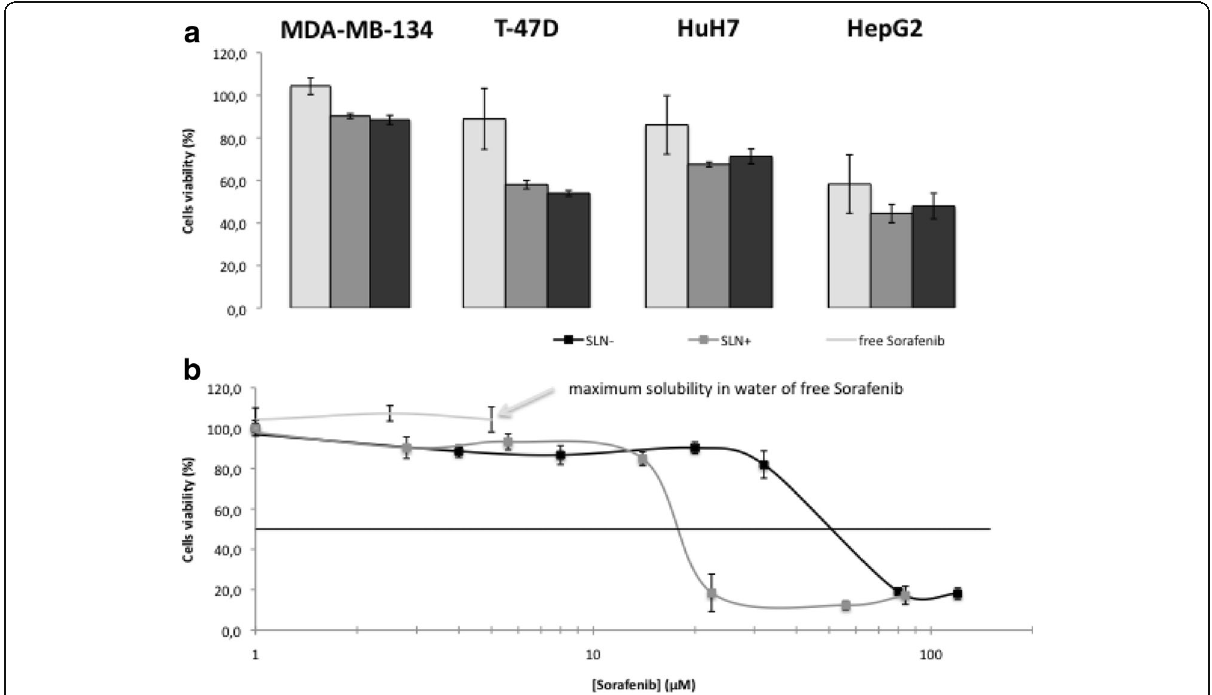
Fig. 4 Cytotoxicity effect of sorafenib or SLNs. a ) Comparison of the cytotoxicity with free Sorafenib or SLNs of Sorafenib in 4 cells lines (2 luminal B breast cancer and 2 hepatocarcinomas) after quantification with MTS assay on 3 wells at 5 μ M of free Sorafenib, 2.8 μ M of NPs Sorafenib/DOTAU (SLN+) and 4 μ M of NPs Sorafenib/diC16dT (SLN-). b ) Cell viability assay (MDA-MB-134 cells) in the presence of free sorafenib (limited of solubility ), SLN+ (grey) or SLN-